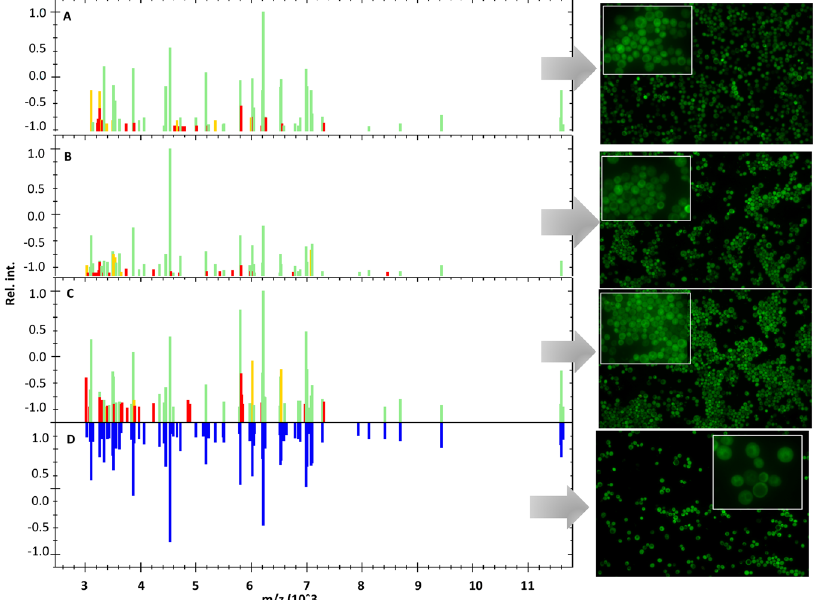
Figure 4. MALDI-TOF MS spectra and microscopic images of S . cerevisiae suspended in 5 mM Ca(NO 3 ) 2 solution at pH = 6 ( A ), pH = 8 ( B ), pH = 9 ( C ) and native S . cerevisiae ( D ), where green signals are correlated with control sample, yellow signals are shifted and red signals are disappeared in compare with native sample.